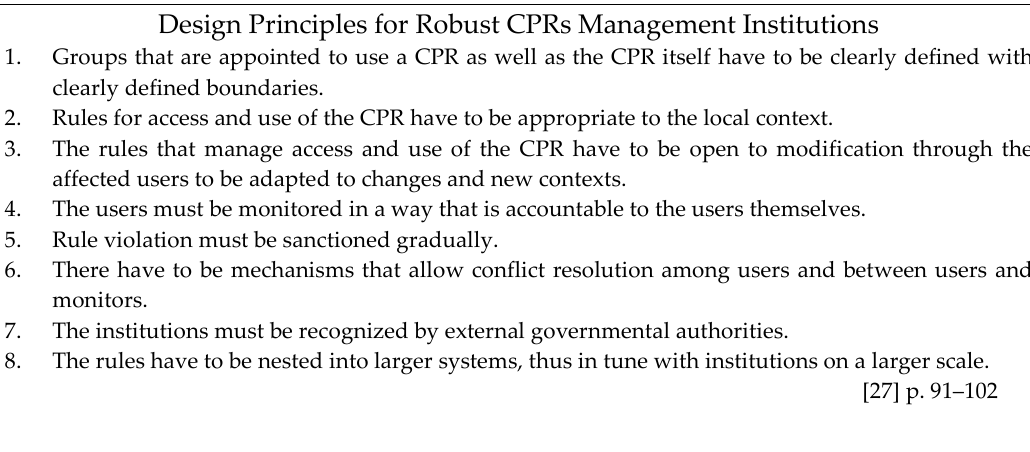
Figure 1. Table of Design Principles for Robust CPR Management Institutions according to Ostrom [27] .